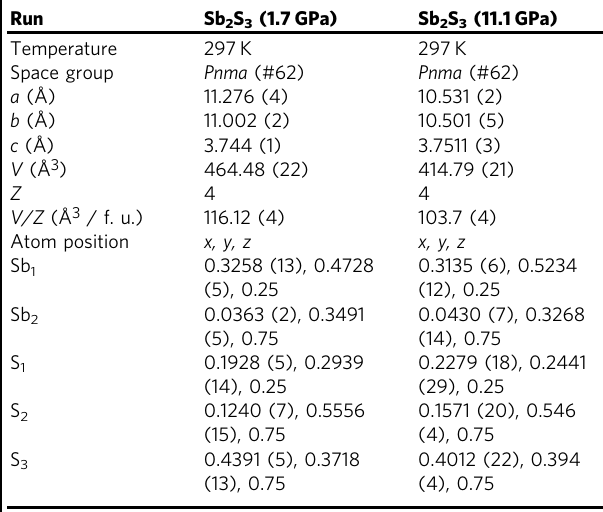
At 1.7GPa, Sb 2 S 3 is the original layered structure. The sample undergoes an isostructure phase transition, and the group movement of S atoms mainly contribute to the build-up of the 3D structure at high pressure. Details of single-crystal re fi nement are in Supplementary Table